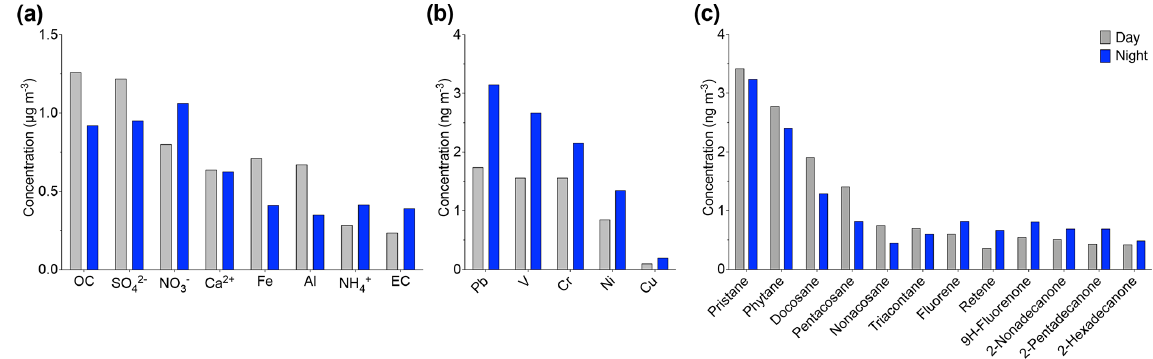
Figure 9. Day and nighttime variation of (a) OC, EC, ionic chemical species, (b) anthropogenic metals, and (c) organic compounds such as alkanes, PAHs, and alkane-2-ones.